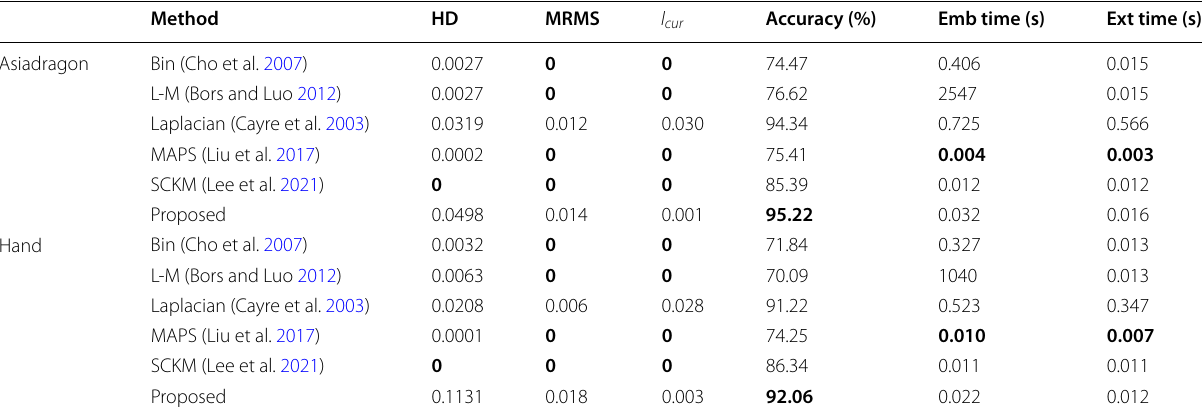
Table 1 Quantitative comparisons with baseline methods on Hand and Asiadragon dataset